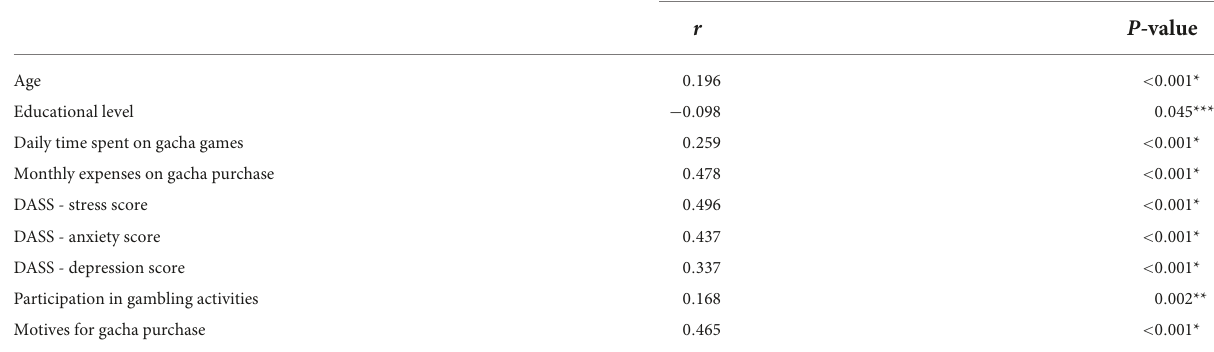
TABLE 3 Correlations between total PGSI score and study variables ( N